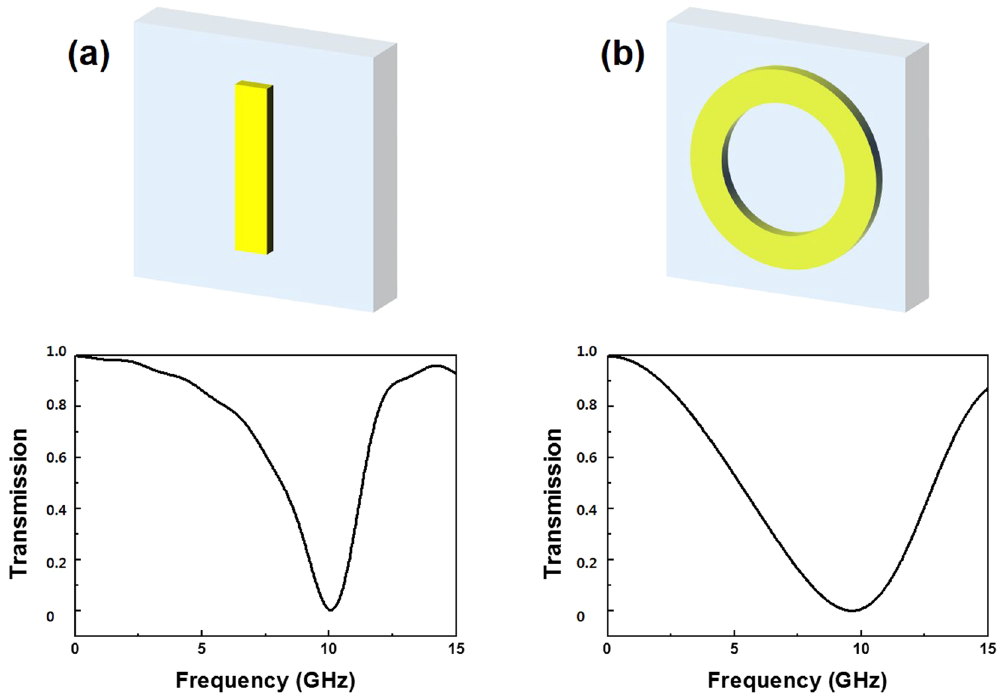
Figure 2. Simulated spectra of the transmission at the normal incidence for ( a ) CWR alone ( b ) RR alone.